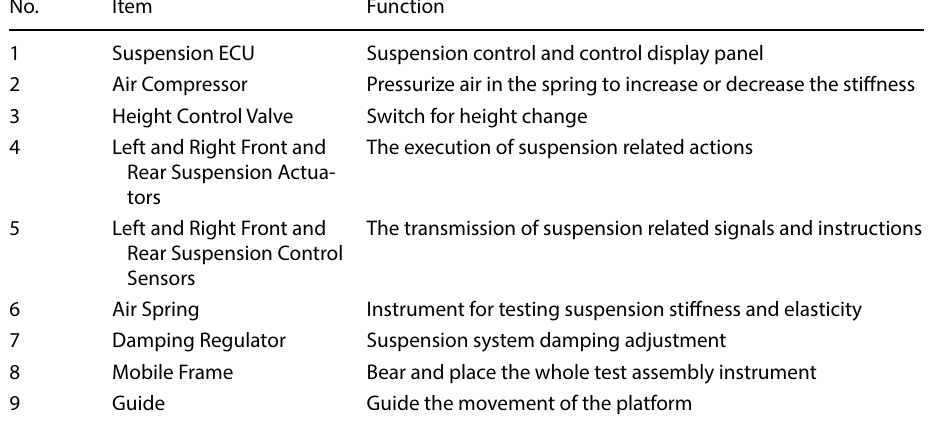
Table 2 Main Components of the Active Suspension